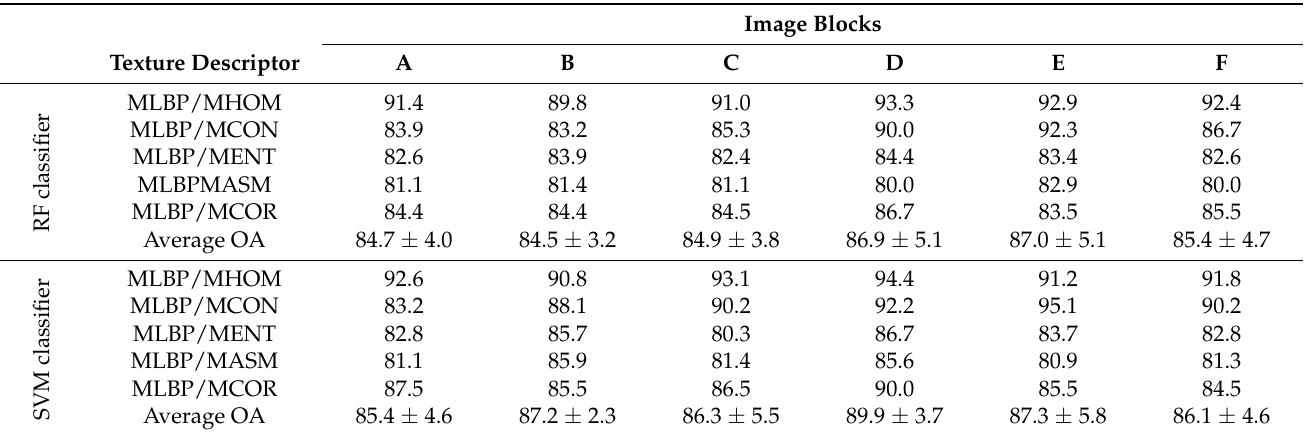
Table 5. The overall accuracy results of the six image blocks.